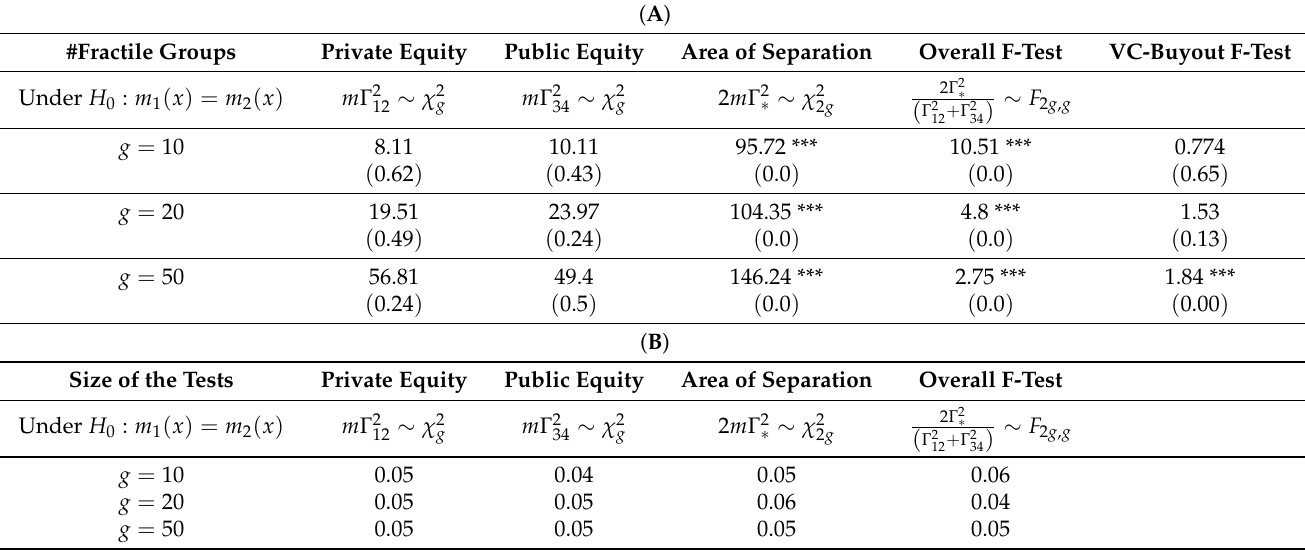
Table 3. Hypothesis tests based the FGA using bootstrapped standard errors for private and